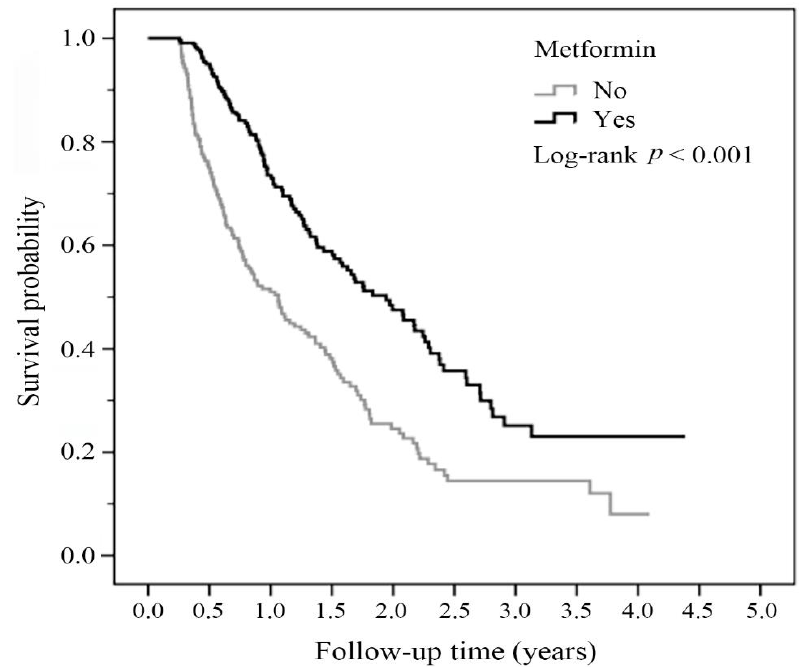
Figure 2. Overall survival status of the study groups classified by metformin and non-metformin treatment. The survival probability was analyzed by the Kaplan-Meier method during 4.0 – 4.5 years of follow-up. The p value for the log-rank test was p < 0.001.